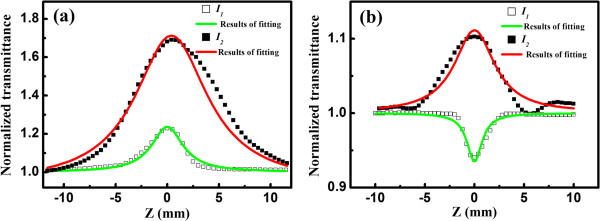
Open aperture Z-scan traces of samples D and E. (a) Sample D and (b) sample E under two laser intensity, I1 = 3.54 × 1011 W/cm2 (open square) and I2 = 3.54 × 1012 W/cm2 (full square). The solid lines are the fitting curves of the experimental data.